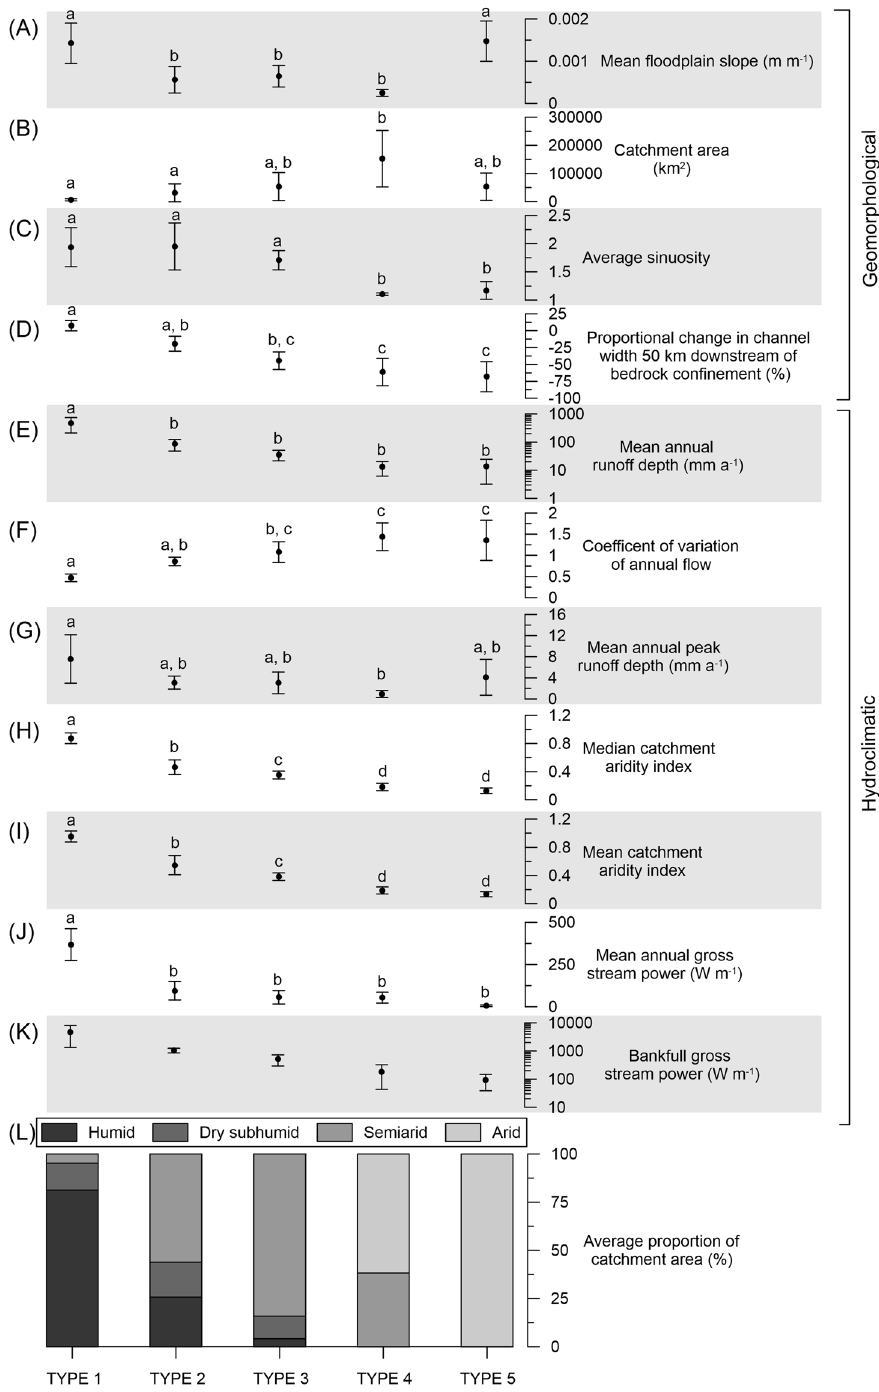
Figure 3. Comparison of the five river types based on 11 geomorphological and hydroclimatic variables. Plots show mean plus error bars representing one standard deviation (Type 1, n = 4; Type 2, n = 5; Type 3, n = 9; Type 4, n = 6; Type 5, n = 4). One-way ANOVAs were performed to identify statistically significant differences between river types for each variable. Points sharing the same letter are not significantly different according to Tukey’s honest significant difference (HSD) test. ( A ) No systematic trend between floodplain slope and river type. ( B ) No systematic trend between catchment area and river type, although Types 1 and 2 tend to have smaller catchments. ( C ) Significant differences between sinuosity and river type, with Types 1, 2, and 3 having significantly higher sinuosity than Types 4 and 5. ( D ) Negative correlation between rate of downstream change in channel size and river type. ( E ) Negative correlation between mean annual runoff depth and river type, although the only significant difference is between Type 1 and the other types. ( F ) Positive correlation between CV af and river type, albeit with substantial overlap between types. ( G ) Weak negative correlation between mean annual peak runoff depth and river type. ( H ) Significant differences between river types explained by